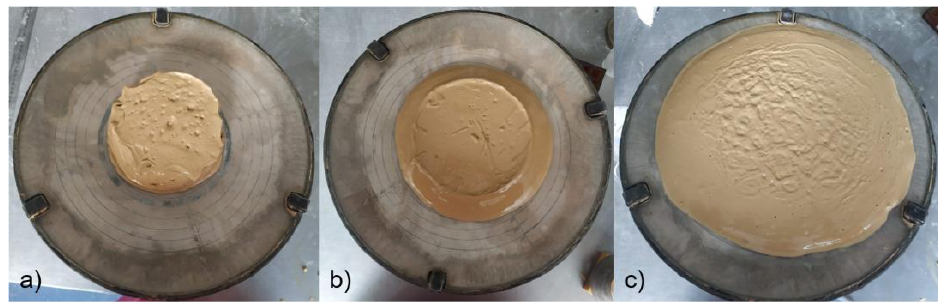
Figure 3. ( a ) Flow test of a fresh paste (FA-5); ( b ) initial flow diameter of a binder with higher viscosity (NS1-5); ( c ) diameter after jolting 15 times